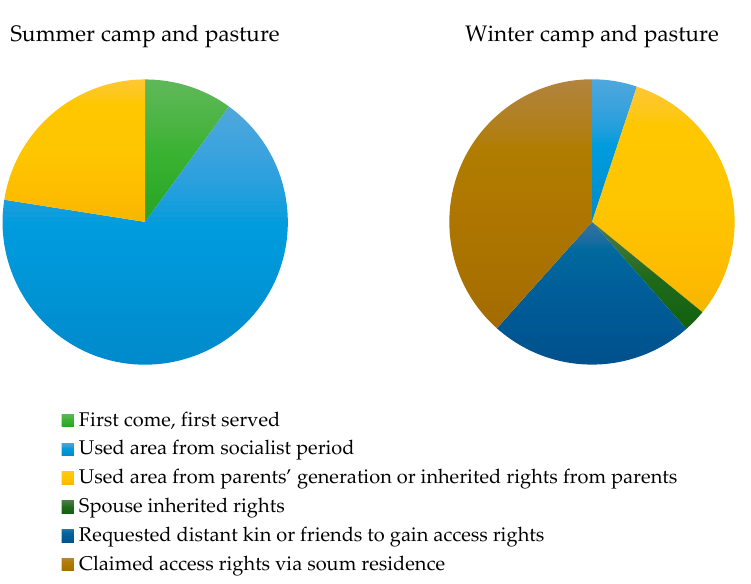
Figure 3. Source of camp selection and pasture in the Altanbulag soum. Data source: Fernández- Giménez [36].